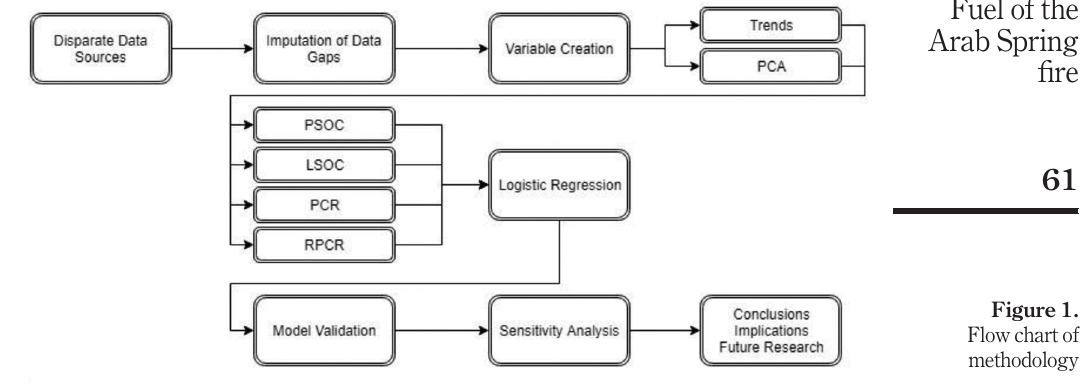
Figure 1. Flow chart of